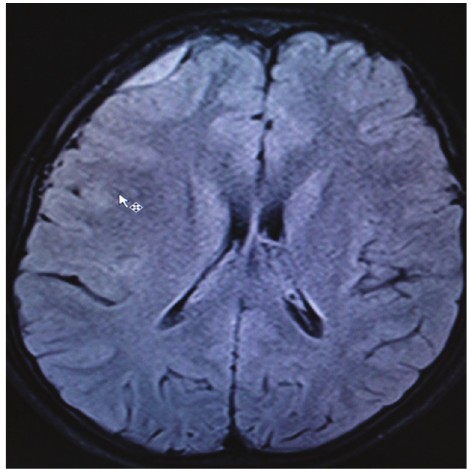
Figure 4: Axial fluid attenuated inversion recovery MR image showing broad dural based extra-axial en plaque meningiomas at right frontal region.